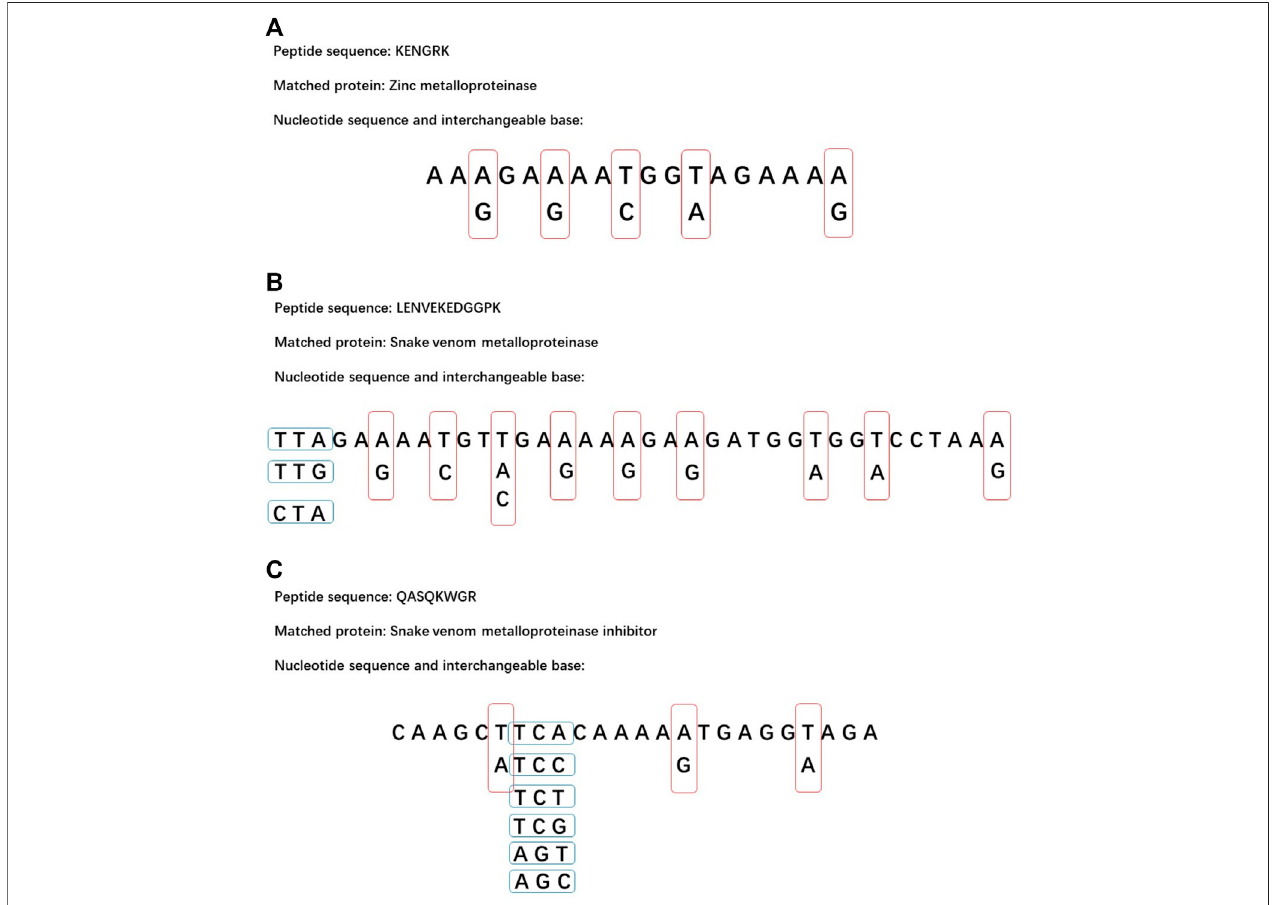
FIGURE 7 | Possible nucleotide sequence of three important peptides. The red and blue frames represent interchangeable bases. (A) The sequence of KENGRK. (B) The sequence of LENVEKEDGGPK. (C) The sequence of QASQKWGR.